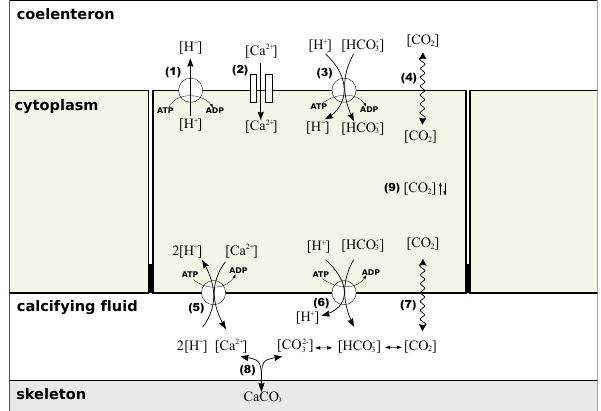
Fig. 2. Processes considered in the model. (1) active proton pump (Allemand et al., 2004), (2) passive calcium channel (Zoccola et al., 1999; Allemand et al., 2004), (3) active uptake of bicarbonate (Furla et al., 2000), (4) CO 2 diffusion (Sueltemeyer and Rinast, 1996), (5) active calcium transport (Ip et al., 1991; Zoccola et al., 2004), (6) active bicarbonate transport (Furla et al., 2000), (7) CO 2 diffusion (Sueltemeyer and Rinast, 1996), (8) aragonite precipitation (Burton and Walter, 1990), (9) photosynthesis and respiration (Al-Horani et al.,